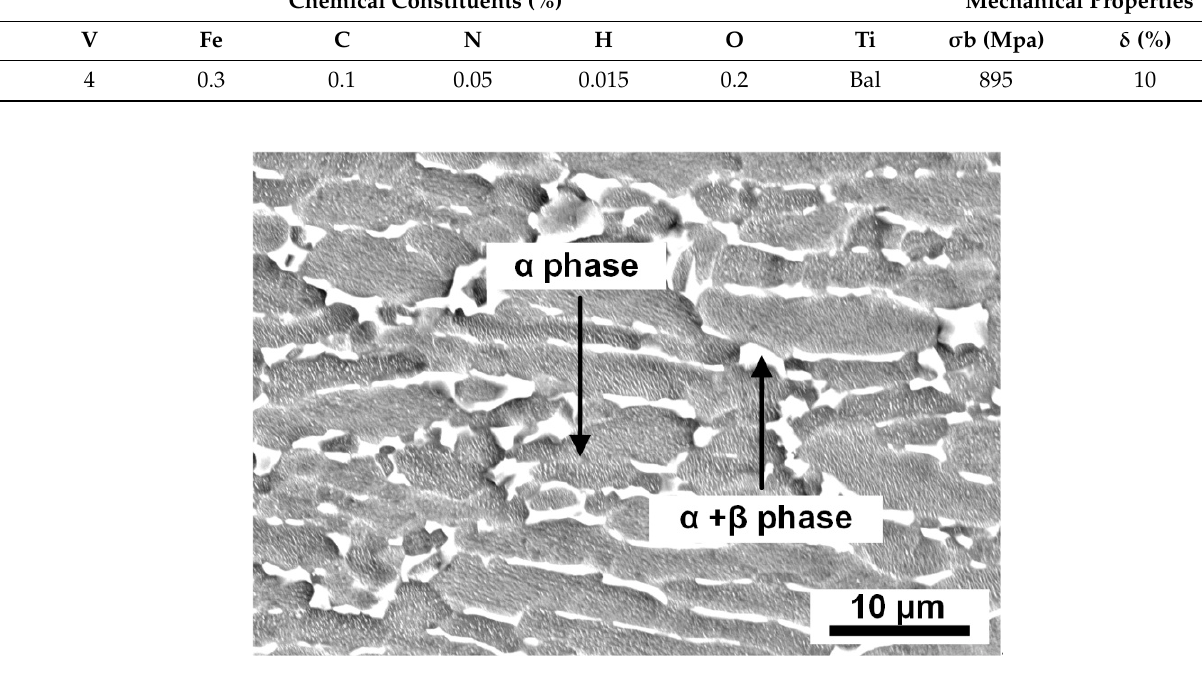
Table 1. Main chemical constituents and mechanical properties of Ti-6Al-4V titanium alloy.